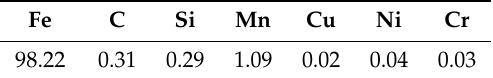
Table 1. The composition of the rebar.